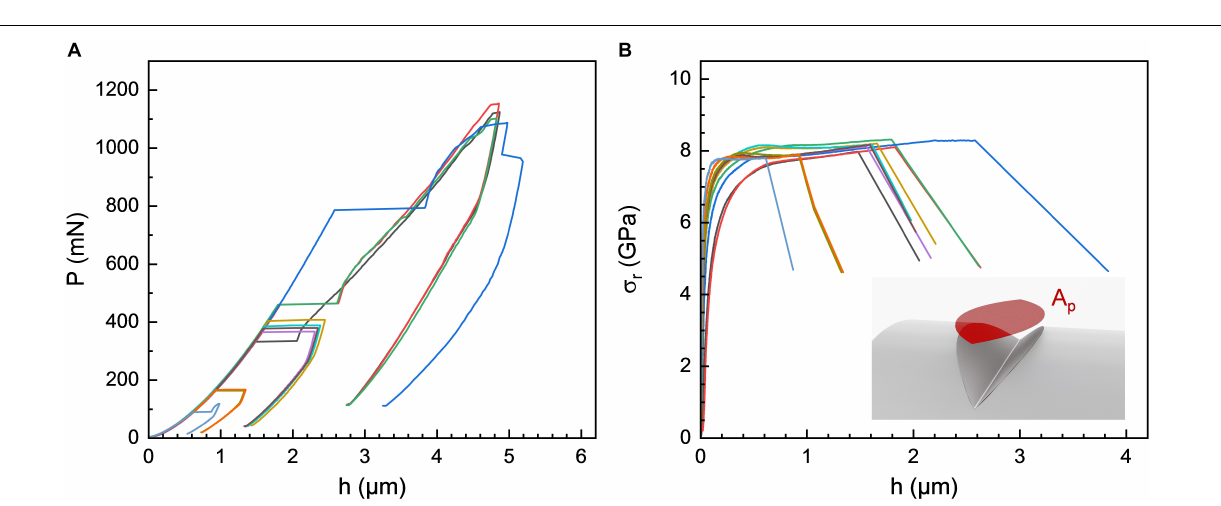
FIGURE 7 | (A) Examples of load-displacement P - h curves recorded from nanoindentation experiments on a 220 µ m silica glass fiber using a wedge-shaped tip with an opening angle of 60 ◦ and an effective length of 180 µ m. (B) Corresponding depth profiles of the representative mean indentation stresses σ r . In (B) , data are presented up to the occurrence of the first pop-in